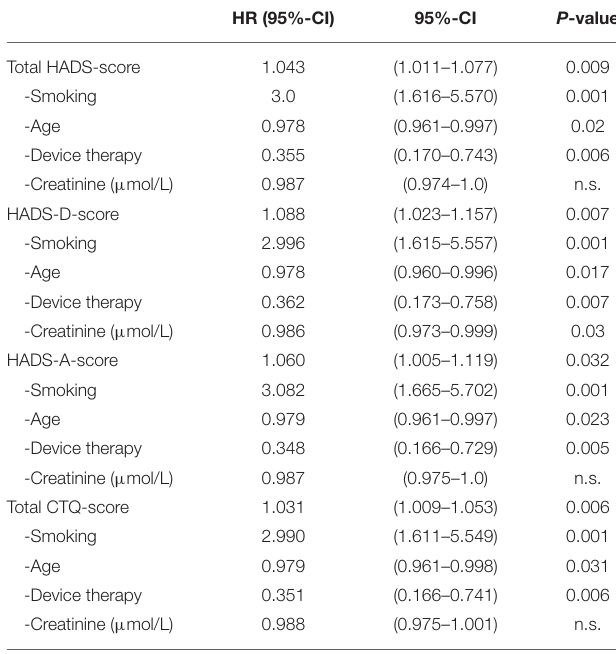
TABLE 3 | Multivariate predictors of (non)-adherence to medication in adults congenital heart